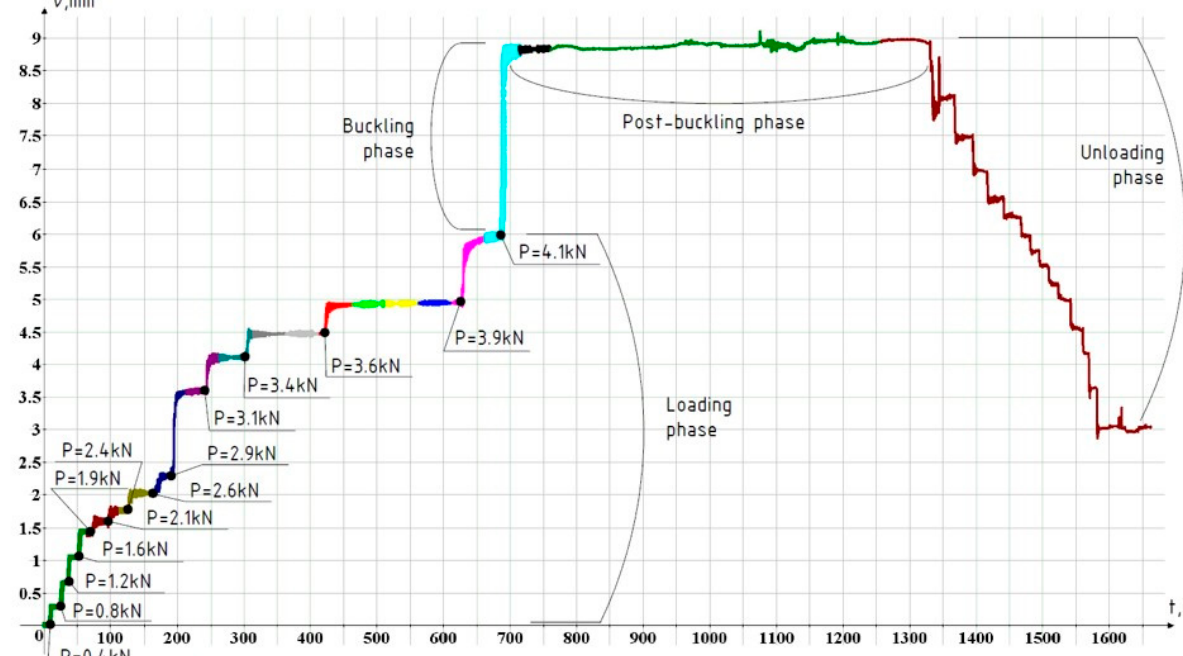
Figure 17. Dependence of de fl ections, mm ( y -axis) on time, s ( x -axis). Experiment No. 1.